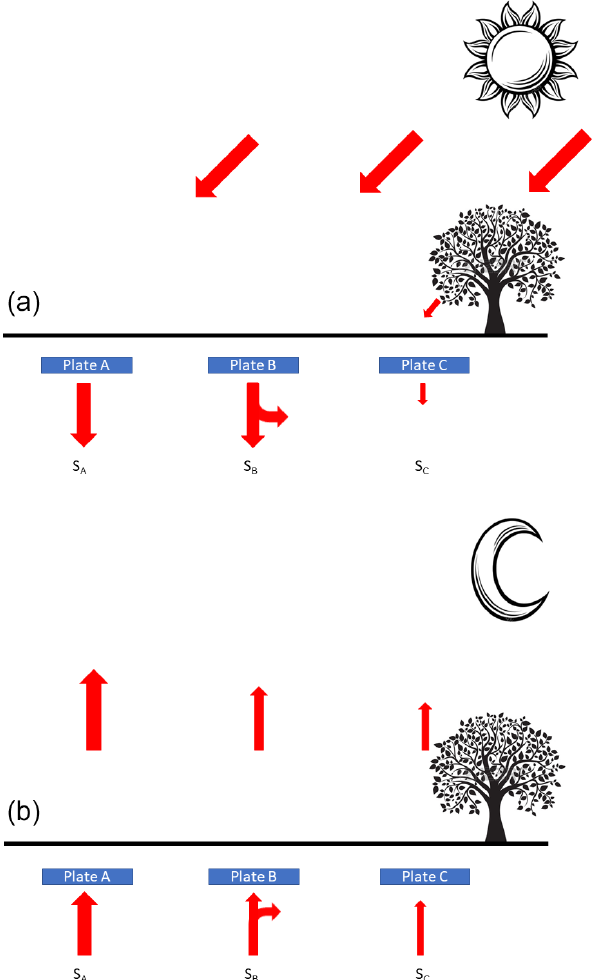
Figure 3. (a) Daylight heat flux on a sunny surface A with result- ing heat storage S A and sunny surface B (Storage S B ) with close shadowed surface C (Storage S C ). (b) Nighttime heat flux resulting from heat storage